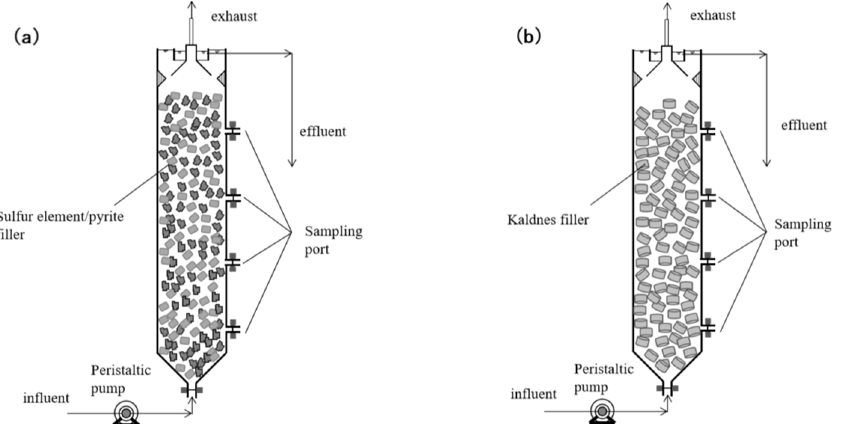
Figure 1. Schematic diagram of the test apparatus: ( a ) The S 0 -SADN operation stage; ( b ) The ANAMMOX start-up stage.